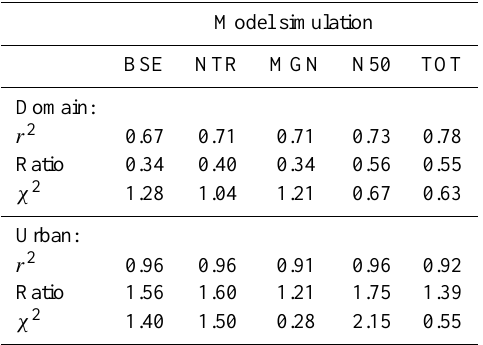
Table 1. Values of the variance ( r 2 ), mean ratio, and reduced chi- squared ( χ 2 ) calculated for all model simulations compared to the DOMINO retrievals of tropospheric column NO 2 .